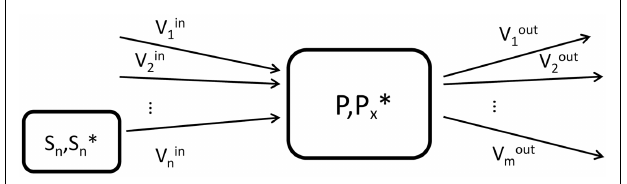
FIGURE 1 | Schematic view of the elementary unit (labeling pool) used in compartment modeling . P is the total concentration of molecules in the labeling pool, while P ∗ represents the concentration of labeled x molecules at the molecular position x . In the general situation, the pool can have n influxes from n substrate pools S n and m